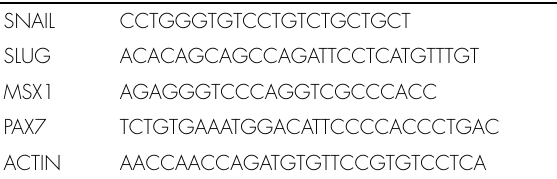
Table III. Probe sequences.